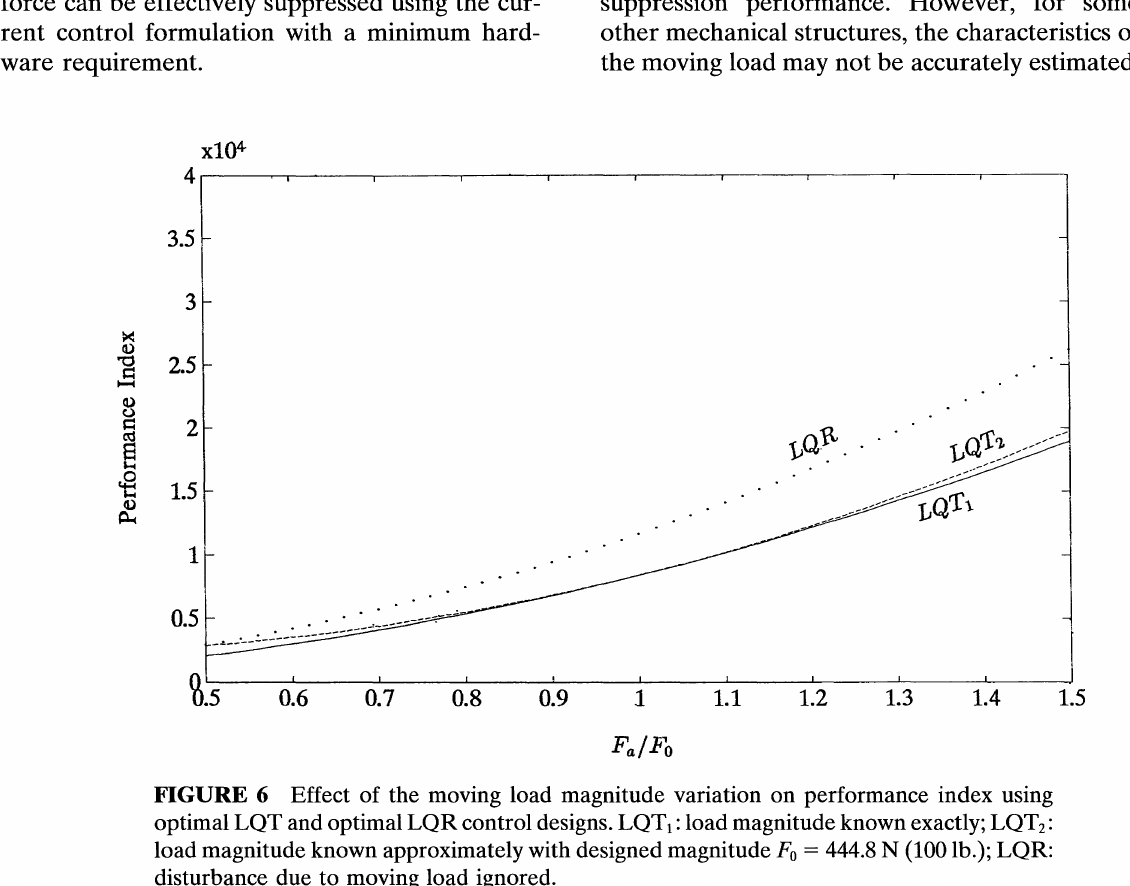
FIGURE 6 Effect of the moving load magnitude variation on performance index using optimal LQT and optimal LQR control designs. LQT): load magnitude known exactly; LQT 2: load magnitude known approximately with designed magnitude Fo = 444.8 N (100 lb.); LQR: disturbance due to moving load